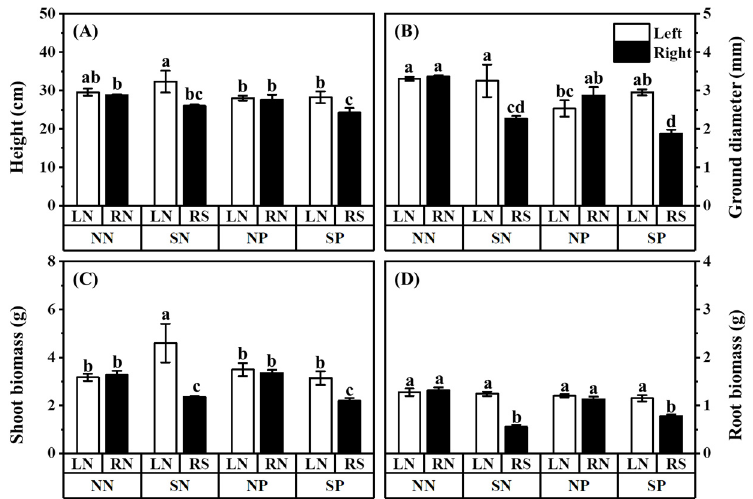
Figure 2. Effects of Pb and shading on the height ( A ), ground diameter ( B ), shoot biomass ( C ), and root biomass ( D ) in M. alba . The data are shown as the means ± standard deviation ( n = 3). F and p -value of ANOVA are listed in Supplementary Table S3. Different letters above the columns in each graph indicate a significant difference among the means by Tukey’s test ( p < 0.05 ). The abbreviation is consistent with Figure 1.